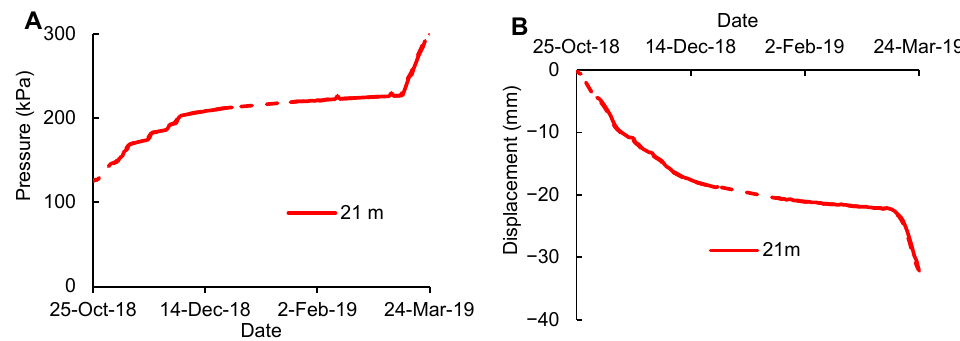
Figure 8. Vertical stress at 21 m and displacement from 16 m to 21 m in the filling areas in the first stage (( A ) is the pressure over time, and ( B ) is the displacement over time. The solid line is the measured data, and the dashed line is the estimation of missing data due to a lack of data).